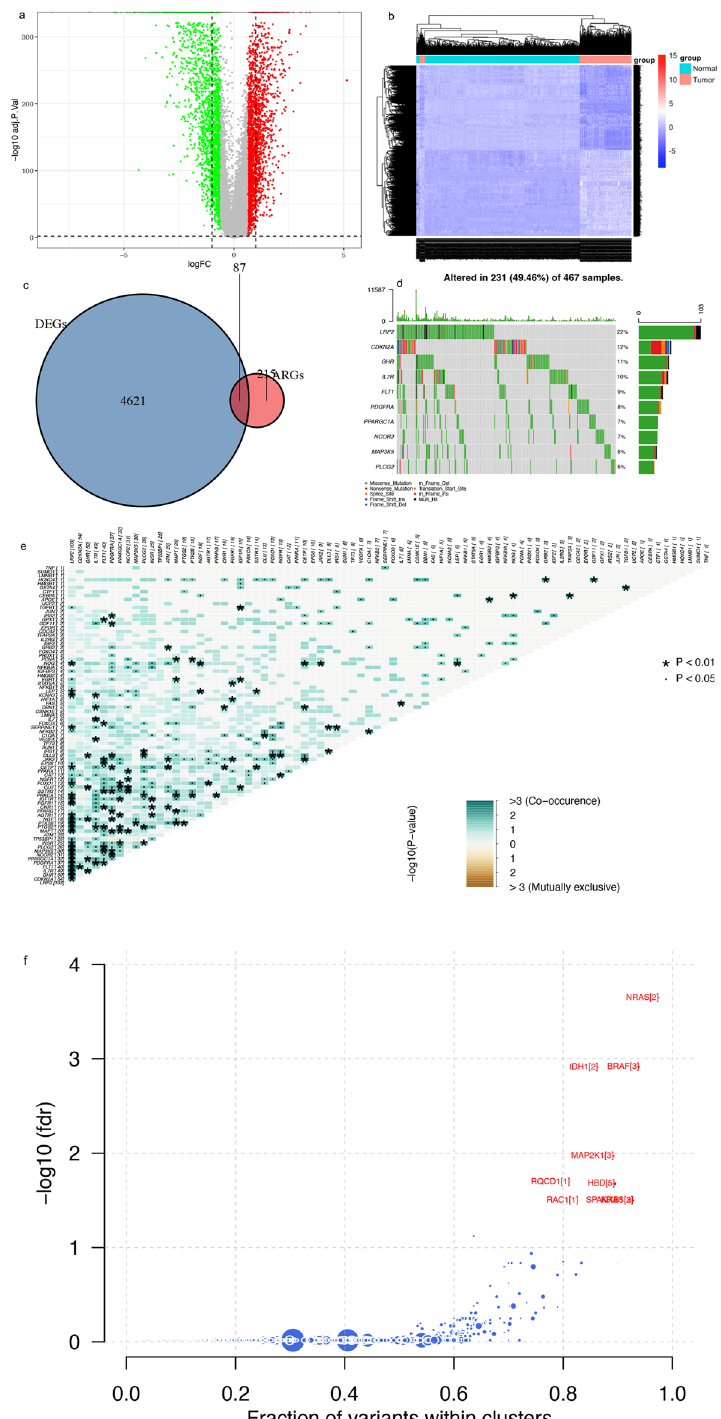
Figure 1. Expression and genetic profiles of ARGs in SKCM. ( a , b ) Volcano and heat maps of DEGs in tumour and normal tissues. ( c ) Intersection of DEGs and ARGs. ( d ) Mutation frequency of differentially expressed ARGs. ( e ) Prediction of driver genes. ( f ) Synergy and mutual exclusivity of ARG mutations. DEG differentially expressed gene, ARG ageing-related